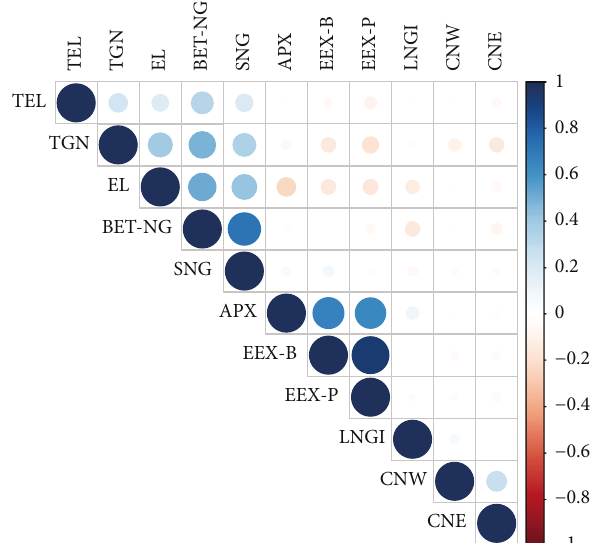
Figure 2: Correlations among selected variables. Source: author’s own work. Notes: variables’ descriptions are provided in Table 2.